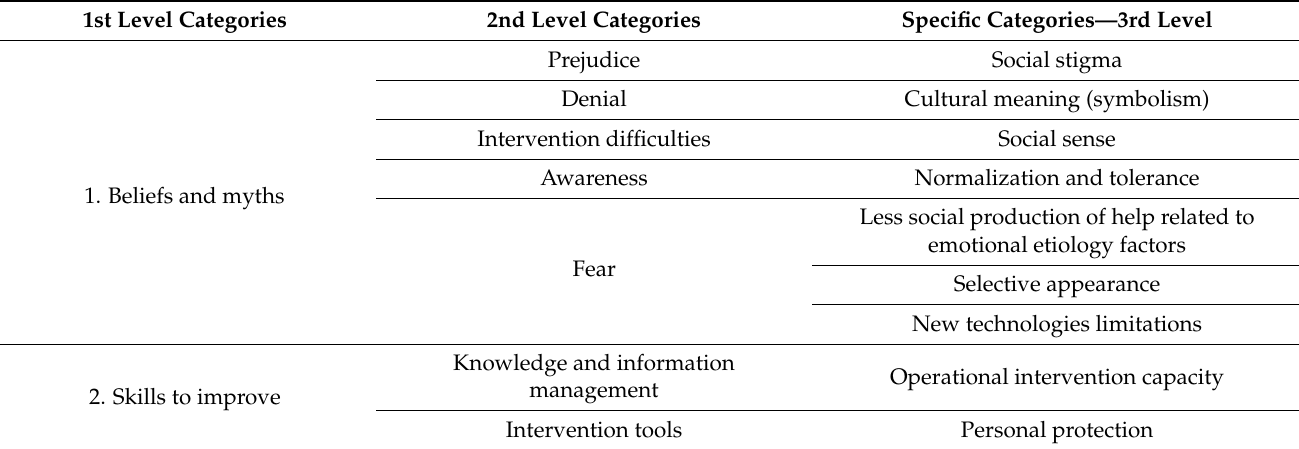
Table 2. Comprehensive list of categories identified after content